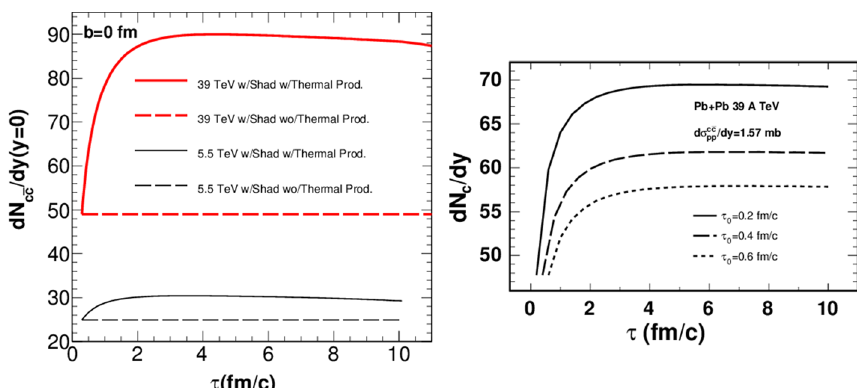
Fig. 16.4 Time-evolution of the cc yield (per unit of rapidity at midrapidity) for central Pb–Pb collisions at √ = 39 TeV s NN